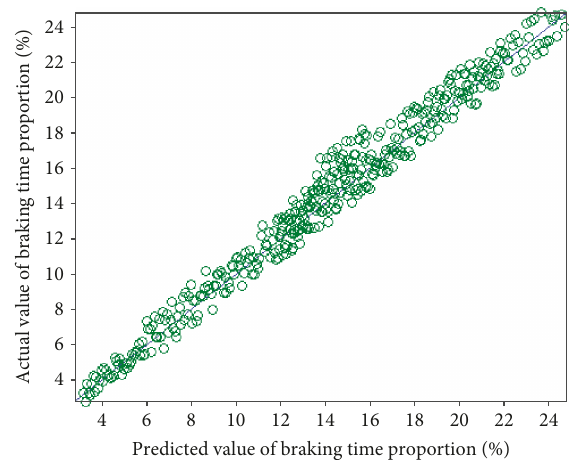
Figure 12: Scatter diagram for predicted value and actual value (energy feedback proportion).